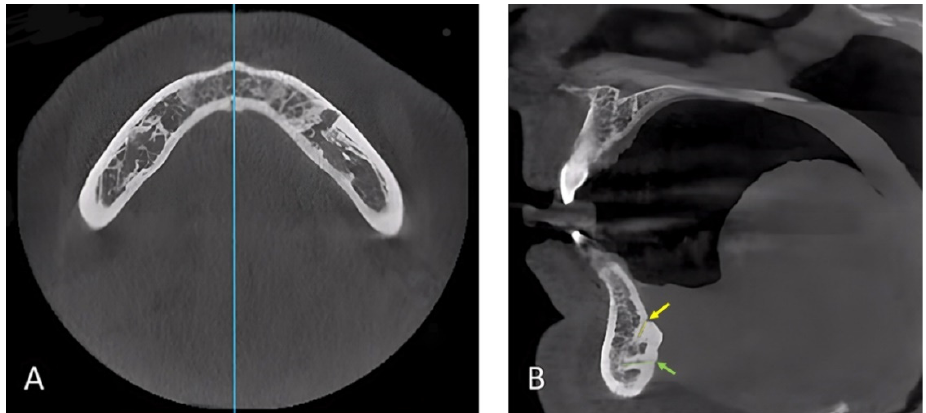
Figure 1. CBCT scan orientation. ( A ) Axial cut at the level of the genial tubercle to orient the midline. ( B ) Sagittal cut at the midline showing the mandibular lingual canals. The yellow arrow points to the supra-spinosum foramen, which is the opening of its corresponding canal (i.e., yellow line). The green arrow points to the infra-spinosum foramen, which is the opening of its corresponding canal (i.e., green line).